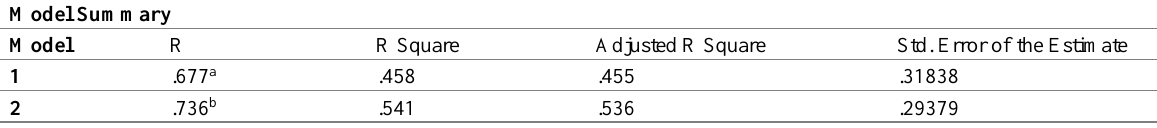
Table 12(a): Model Summary; Entrepreneurial mindset and work